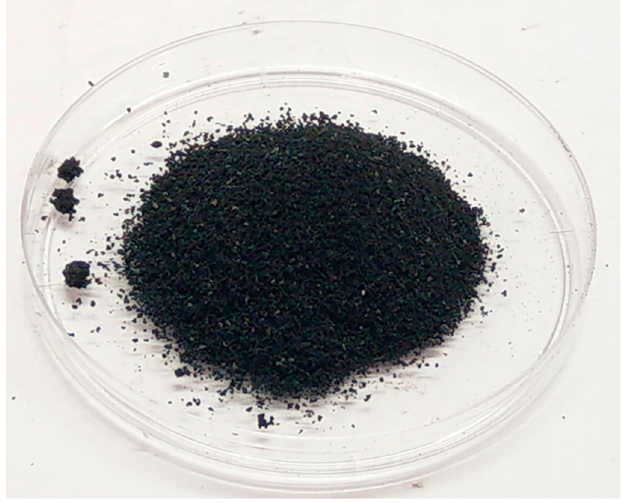
Figure 1. As-received crumb rubber.